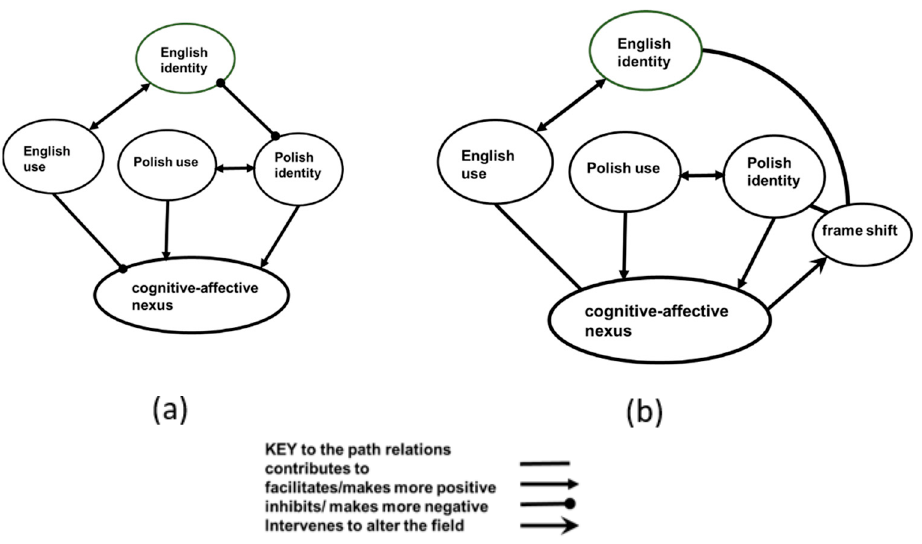
Figure 2. A frame shift intervention designed to accept the perceived incomparability of language use suffused by distinct cultural identities. ( a ) before the intervention, ( b ) after the intervention (please see text for exposition).